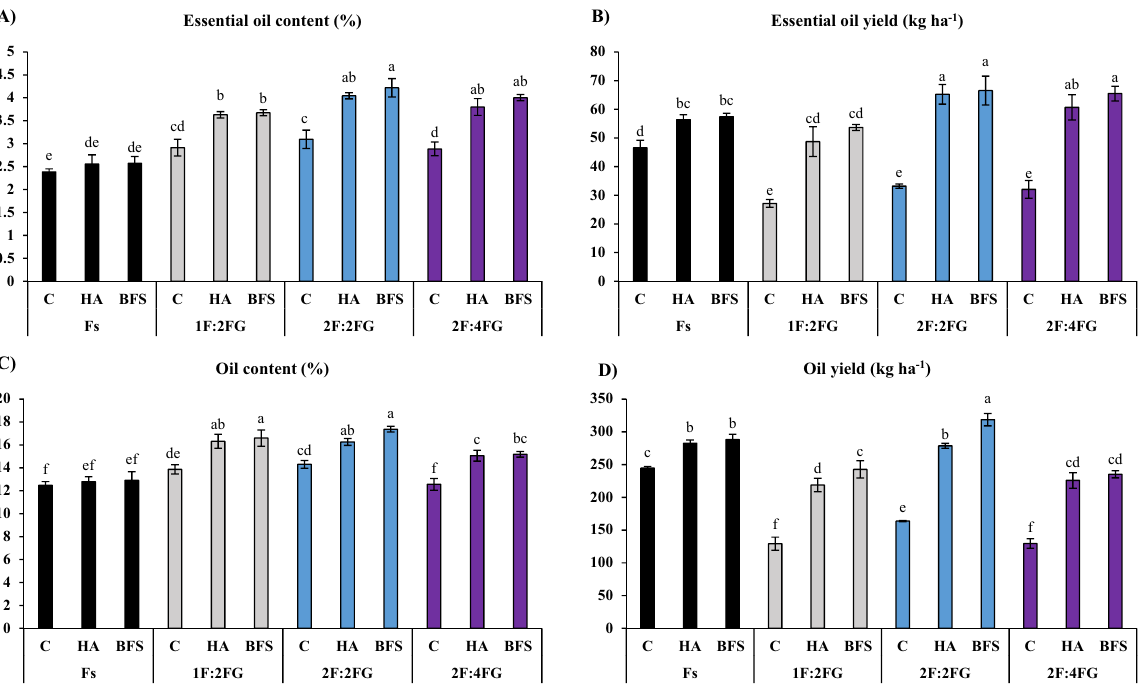
Figure 3. Means comparison for the interaction effect of fertilization [C (control), HA (humic acid), BFS (biofertilizers)] and different cropping patterns [Fs (fennel sole cropping), 1F:2FG, 2F:2FG, 2F:4FG (ratios of fennel and fenugreek in the intercropping patterns)] on essential oil content ( A ), essential oil yield ( B ), oil content ( C ), and oil yield ( D ) of fennel. Different lower-case letters above the bars indicate significant (p ≤ 0.05) differences.